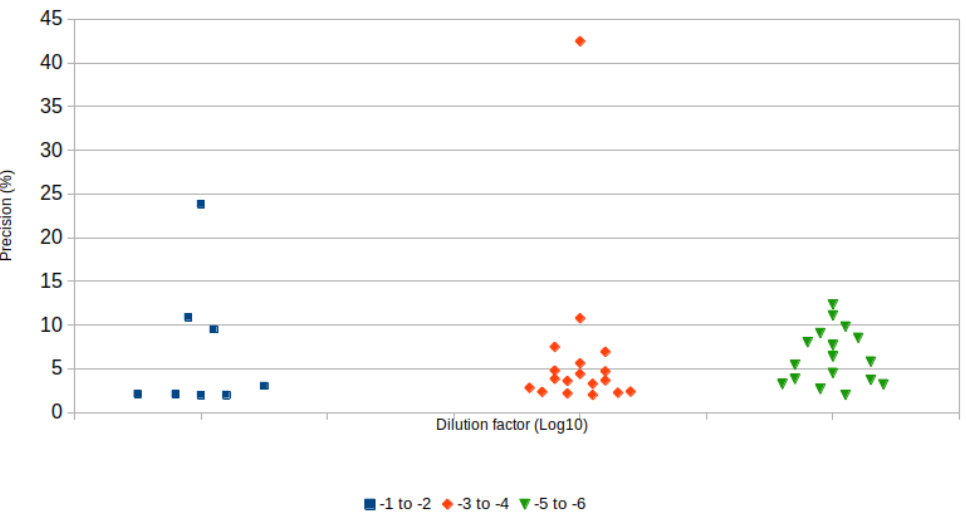
Figure 2. Distribution of precision values (y axis) according to the dilution factor grouped in 10⁻¹ to 10⁻², 10⁻³ to 10⁻⁴ and 10⁻⁵ to 10⁻⁶ (x axis).